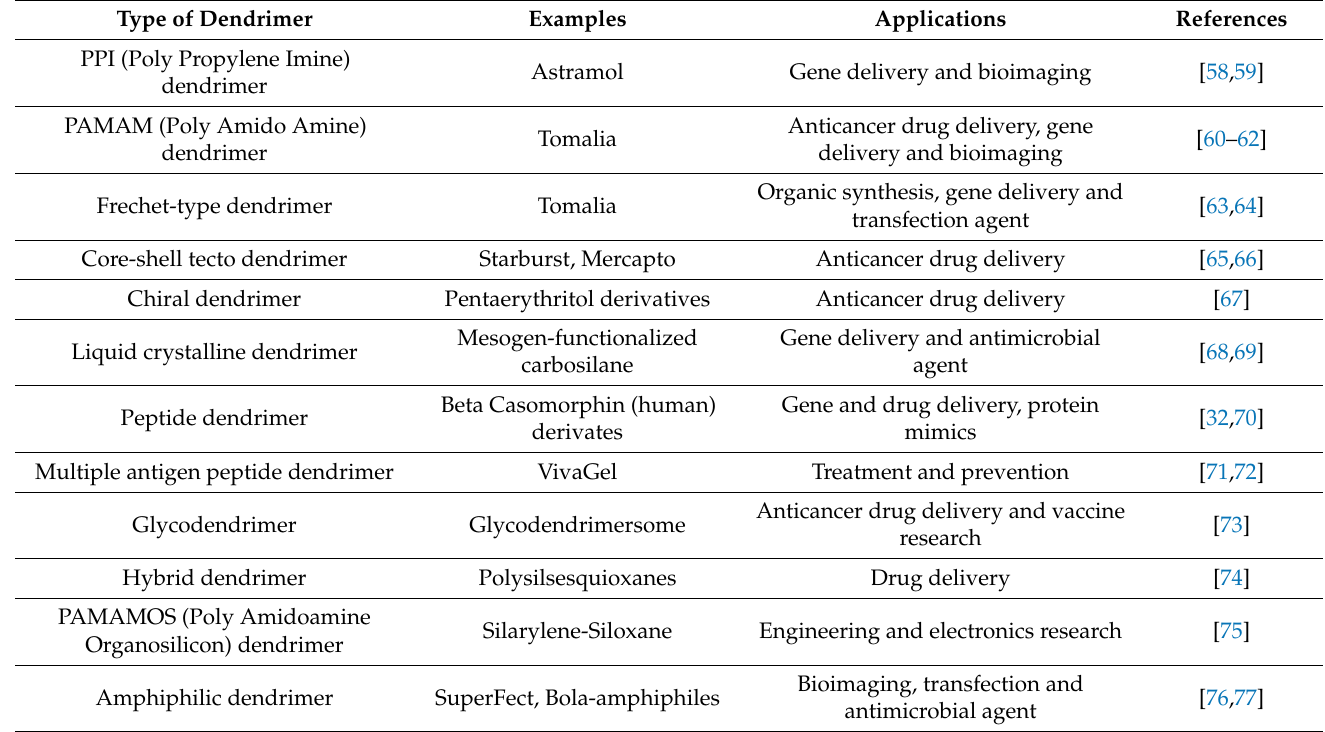
Table 1. Dendrimer types and their